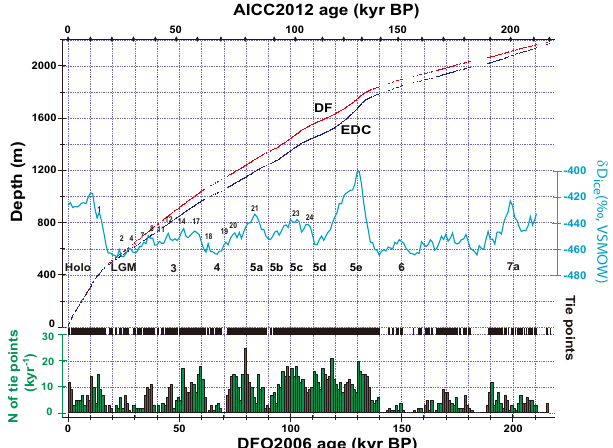
Figure 3. Result of volcanic synchronization: DF depth–EDC depth on a tentative common age scale DFO2006 (bottom axis). AICC2012 scale is also given on the top axis as a reference. Blue trace with indications of the marine isotope stages and Antarctic iso- tope maxima (AIM) is δ D ice of DF core averaged over every 1kyr for reference (Uemura et al., 2012). Black vertical markers are loca- tions of the tie points on the age scale. The green histogram shows the number of tie points found over every 1kyr